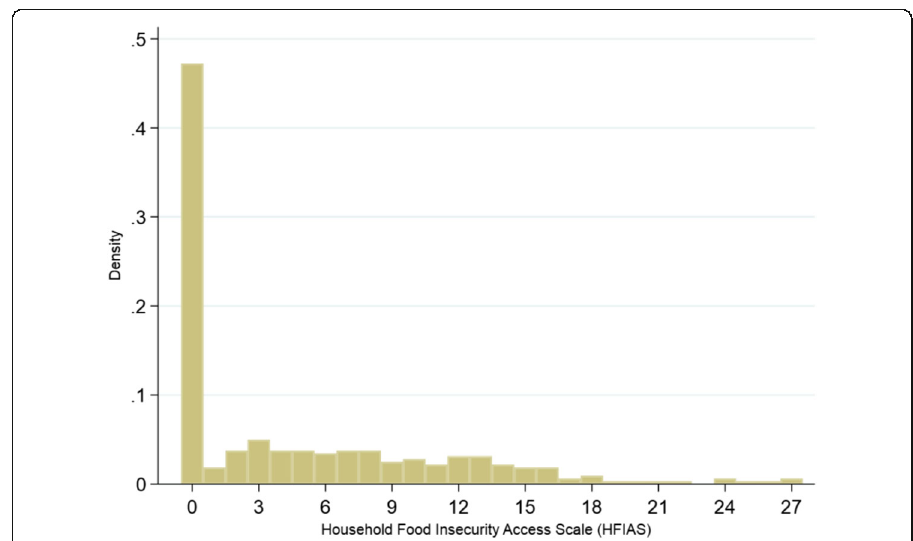
Fig. 5 Distribution of Household Food Insecurity Access Scale (HFIAS) scores. Source: Authors ’ computation using study survey data